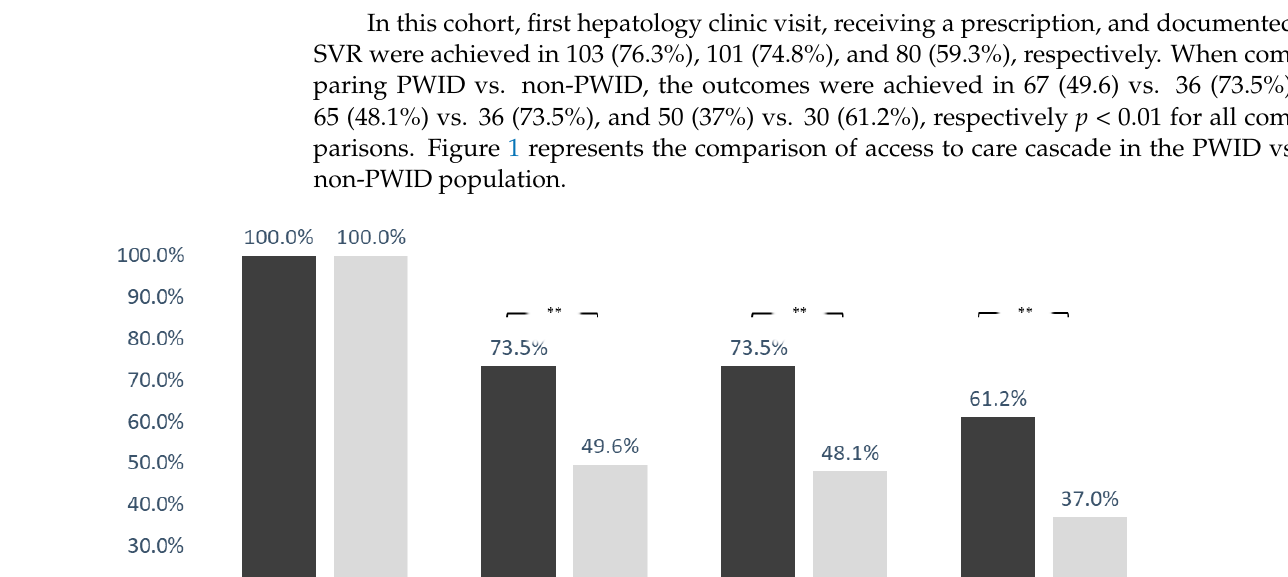
Table 3. Univariate